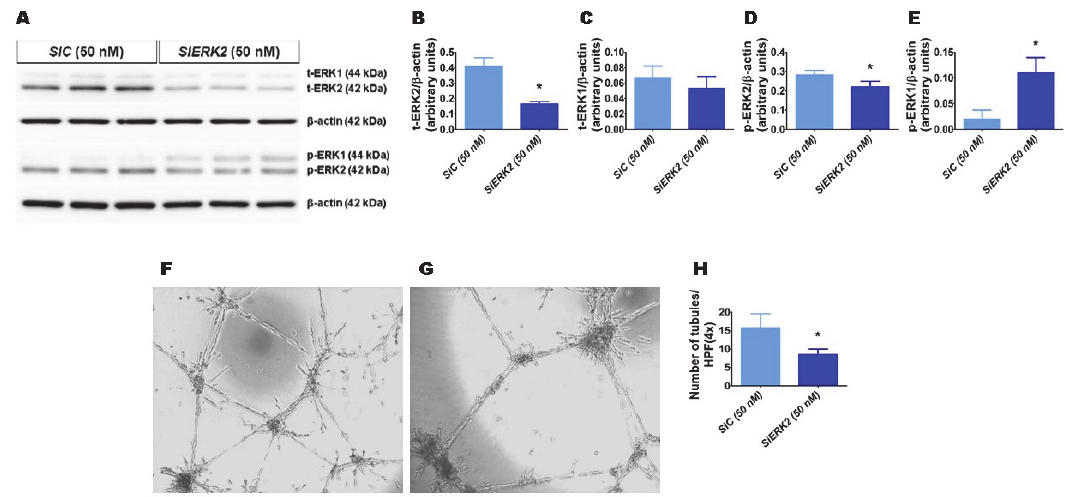
Figure 1. The effects of ERK2 knockdown on human pulmonary microvascular endothelial cell (HPMEC) tubule formation. Control- or ERK2 -siRNA-transfected HPMECs were harvested for protein expression and tubule formation assays. ( A ) The determination of total (t)- and phosphorylated (p)-extracellular signal-regulated kinase (ERK)2 and ERK1 protein levels in control ( SiC )- and ERK2 ( SiERK2) -siRNA-transfected cells by immunoblotting. ( B – E ) Quantification and normalization of t-ERK2 ( B ), t-ERK1 ( C ), p-ERK2 ( D ), and p-ERK1 ( E ) band intensities to those of β -actin. ( F – H ) Representative photographs showing the tubule formation of cells transfected with control ( F ) and ERK2 ( G ) siRNAs. ( H ) Quantification of tubule formation in control ( SiC ) and ERK2 ( SiERK2 ) siRNA-transfected cells. Values are presented as mean ± SD (n = 3 / group for the protein expression studies and n = 7–8 / group for the tubule formation assay). Significant di ff erences between control siRNA- and ERK2 siRNA-transfected groups are indicated by *, p < 0.05 ( t -test). 2.2. Lung ERK2 Expression is Decreased in Endothelial ERK2-Deficient (eERK2 +/ − ) Mice